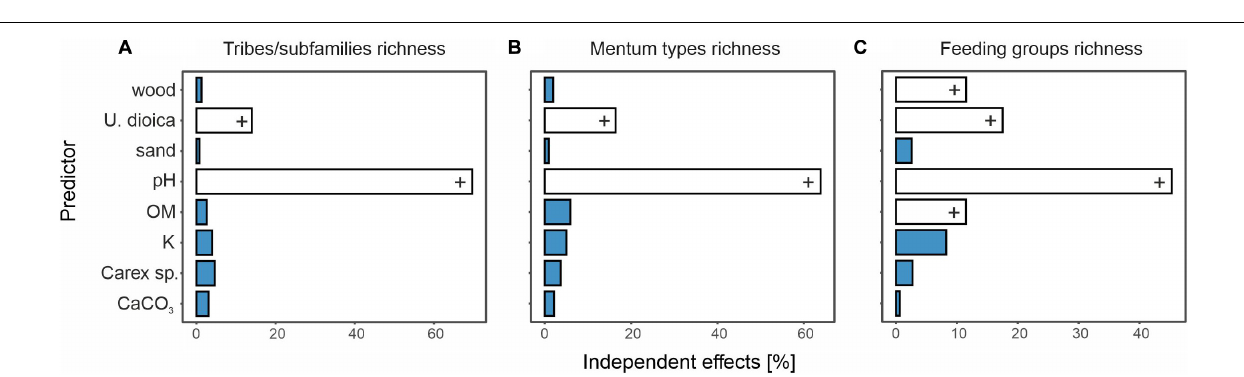
FIGURE 6 | Relative contribution of each predictor to shared variability of full models testing for effects of environmental factors and richness of tribes/subfamilies (A) , mentum types (B) , and feeding types (C) . A positive impact of environmental variables was marked with a plus (+) and negative impact with a minus (–). Predictors with statistical significance of response variables are given in white. For full predictor names, see Supplementary Table 1 .